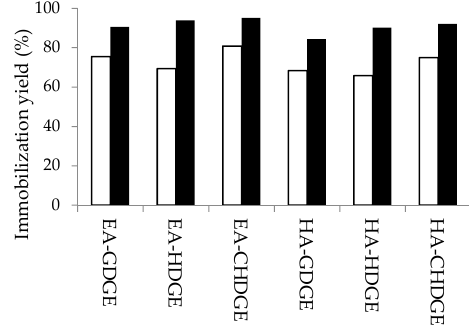
Figure 4. Effect of molar amount of bisepoxide to mass resin ratio on immobilization yields. Supports modified with 2.5 mmol g − 1 bisepoxide ( ); supports modified with 10 mmol g − 1 bisepoxide ( ).